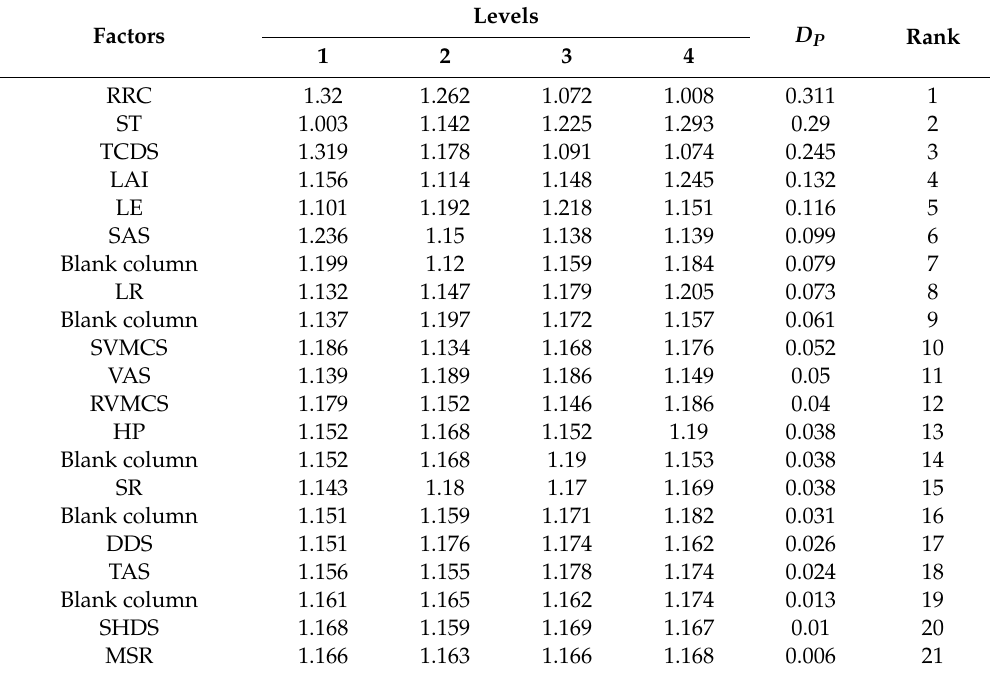
Table 9. Range analysis data and results.